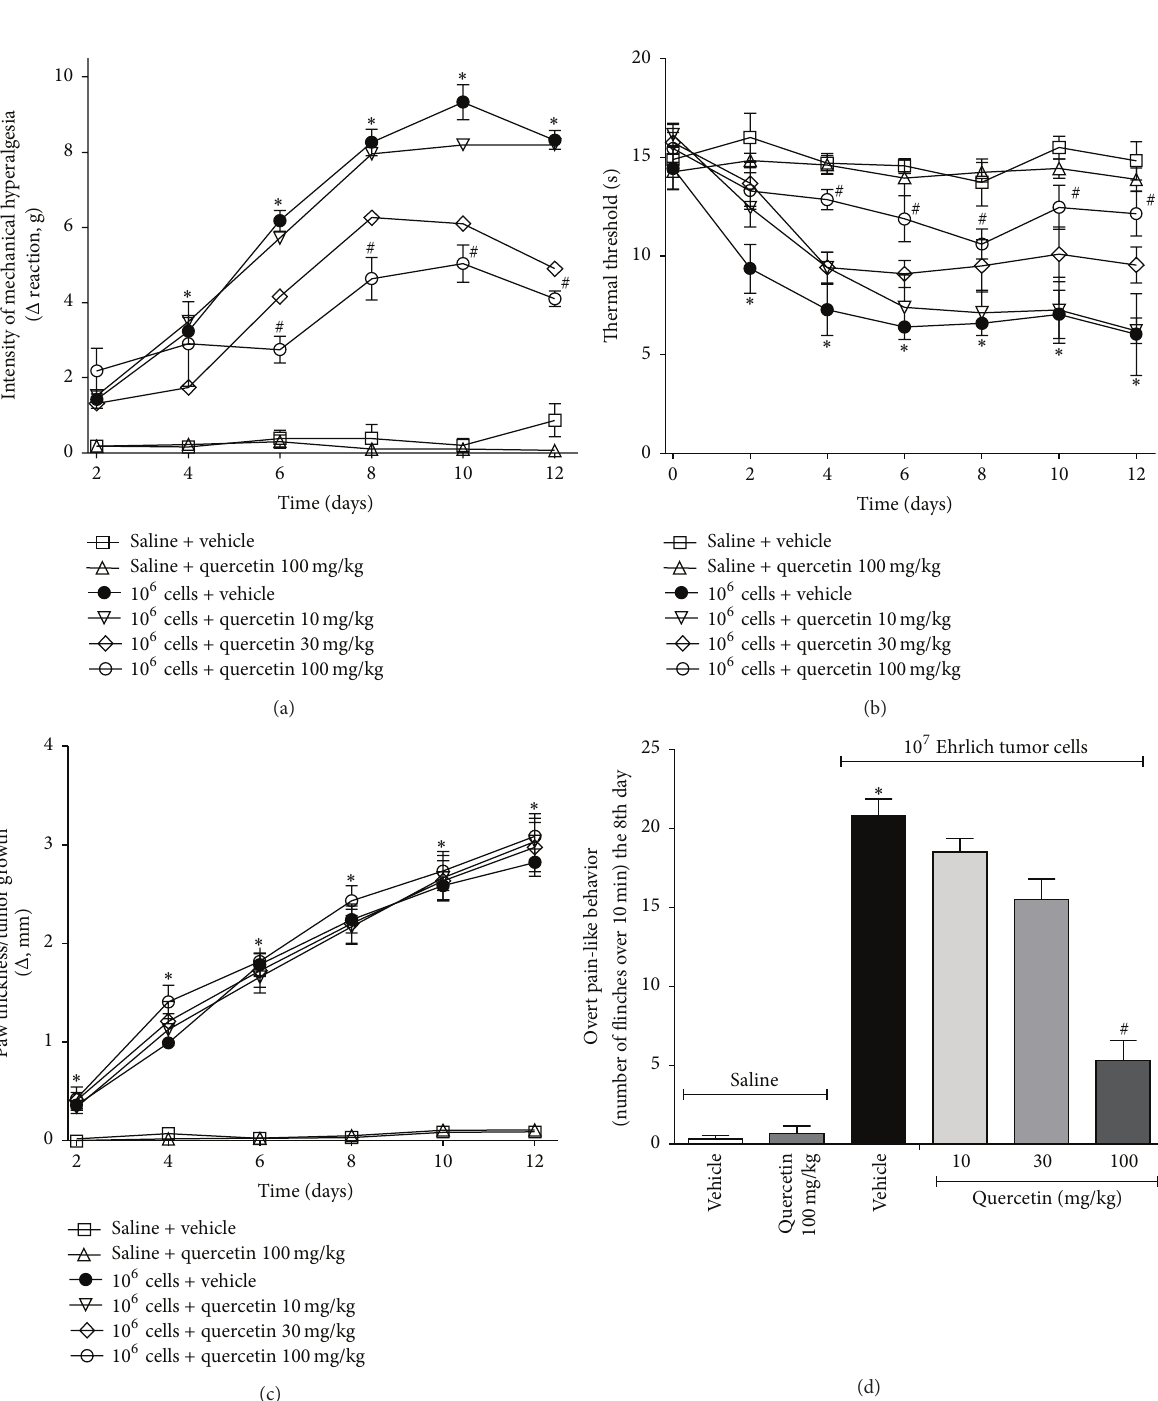
Figure2:Thechronictreatmentwithquercetininhibitsinadose-dependentmannerEhrlichtumor-inducedpain-likebehaviorinmice.Mice received the intraplantar (i.pl.) administration of Ehrlich tumor cells (1 × 10 6 (a–c) or 1 × 10 7 (d)) and were treated daily with quercetin (10, 30, and 100 mg/kg i.p.) during 12 days (a–c) or 8 days (d) starting 10min after tumor injection. The control group of Ehrlich tumor vehicle was saline and saline plus quercetin group was a control of possible per se effects of quercetin. Mechanical hyperalgesia (a), thermal hyperalgesia (b), paw thickness (c), and overt pain-like behavior (d) were evaluated 3 h after the treatment. Data are presented as means ± SEM of six mice per group per experiment and representative of two separated experiments: ∗ 𝑝 < 0.05 compared to the saline group and # 𝑝 < 0.05 compared to the tumor group. One-way ANOVA followed by Tukey’s